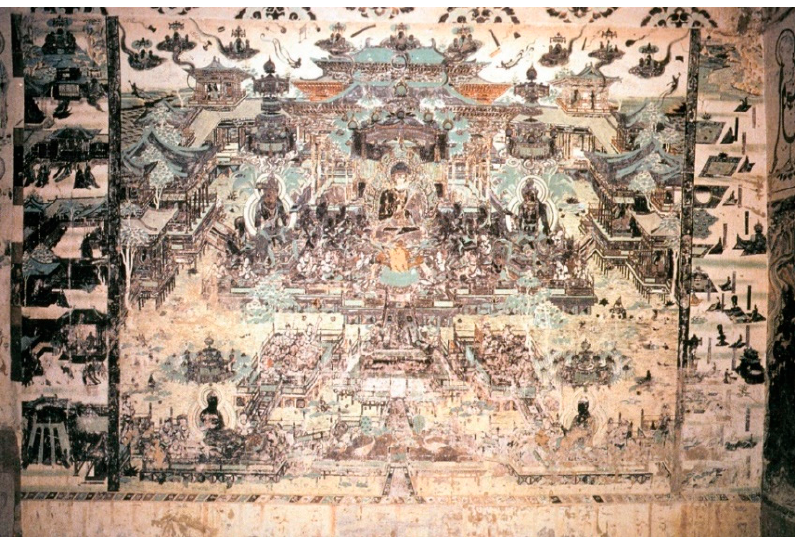
Figure 10. Dunhuang Cave 172: Amitayurdhyana Sutra, south wall, High-Tang (Xiao 1989). Monastic buildings in the upper half of the illustration correspond closely with the scattered platforms floating on the surface of the lotus pool in the lower half of the mural. From the central line between great platforms with a pond and monastic buildings, and the lotus dais on which the Buddha is placed in front of the main hall with five bays, a one-point perspective was employed. This sense of perspective enables the participants to concentrate on the cultivation of visualization meditation. The cults enable the audience to improve their sense of awe toward the Pure Land. The application of the elevated vantage point in the illustration indicates that the Pure Land was far away from the secular world. Moreover, the well-organized spatial depth in the central group of buildings embraces the votaries in the representation of the paradisiac atmosphere with familiar earthly architectural